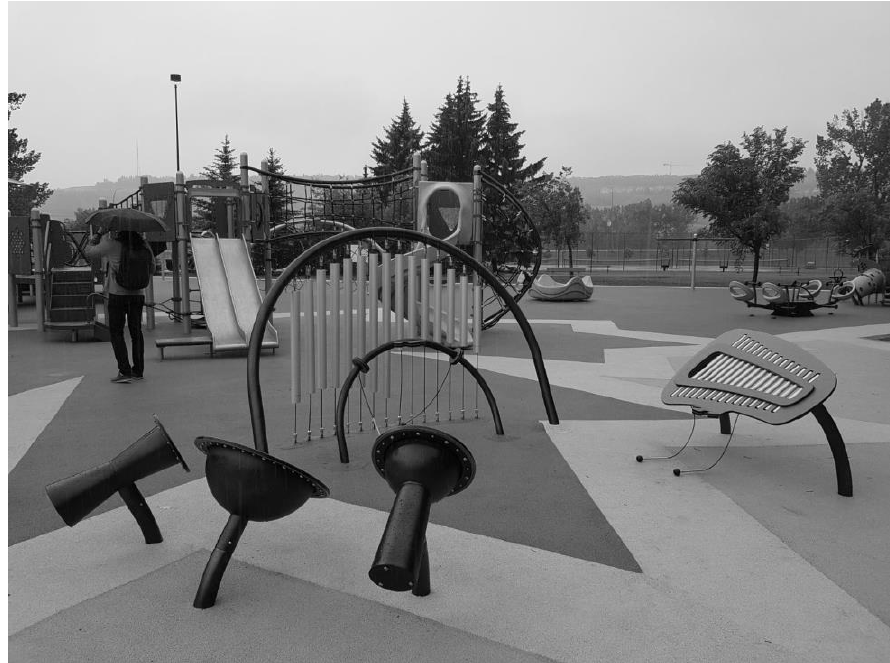
Figure 1. Image depicting part of the music/sensory section of the observed playground.